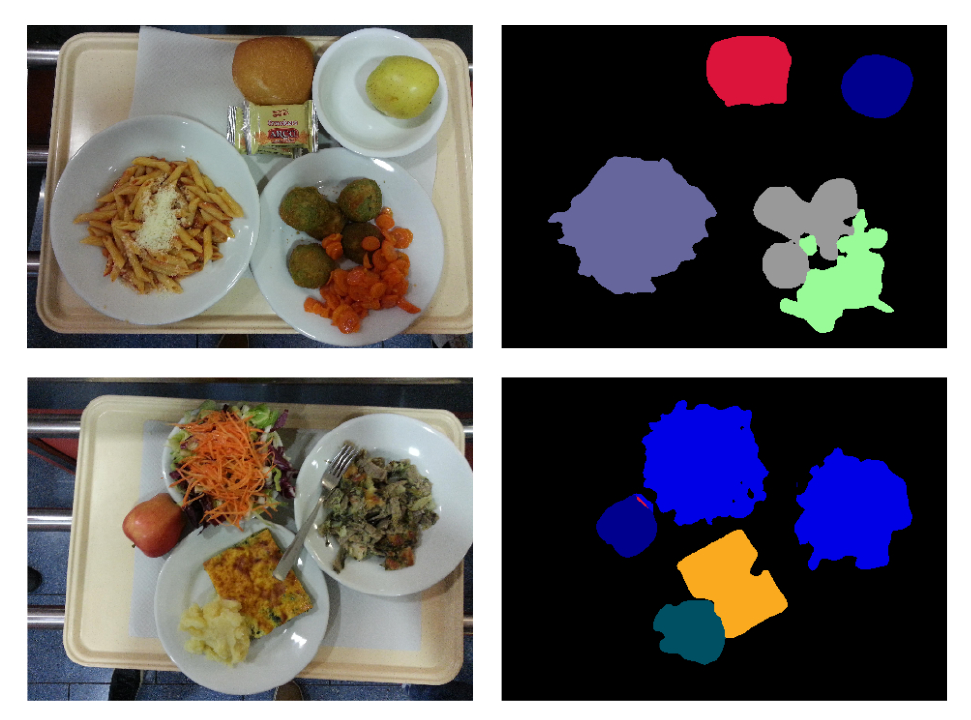
Figure 1. Food segmentation examples using